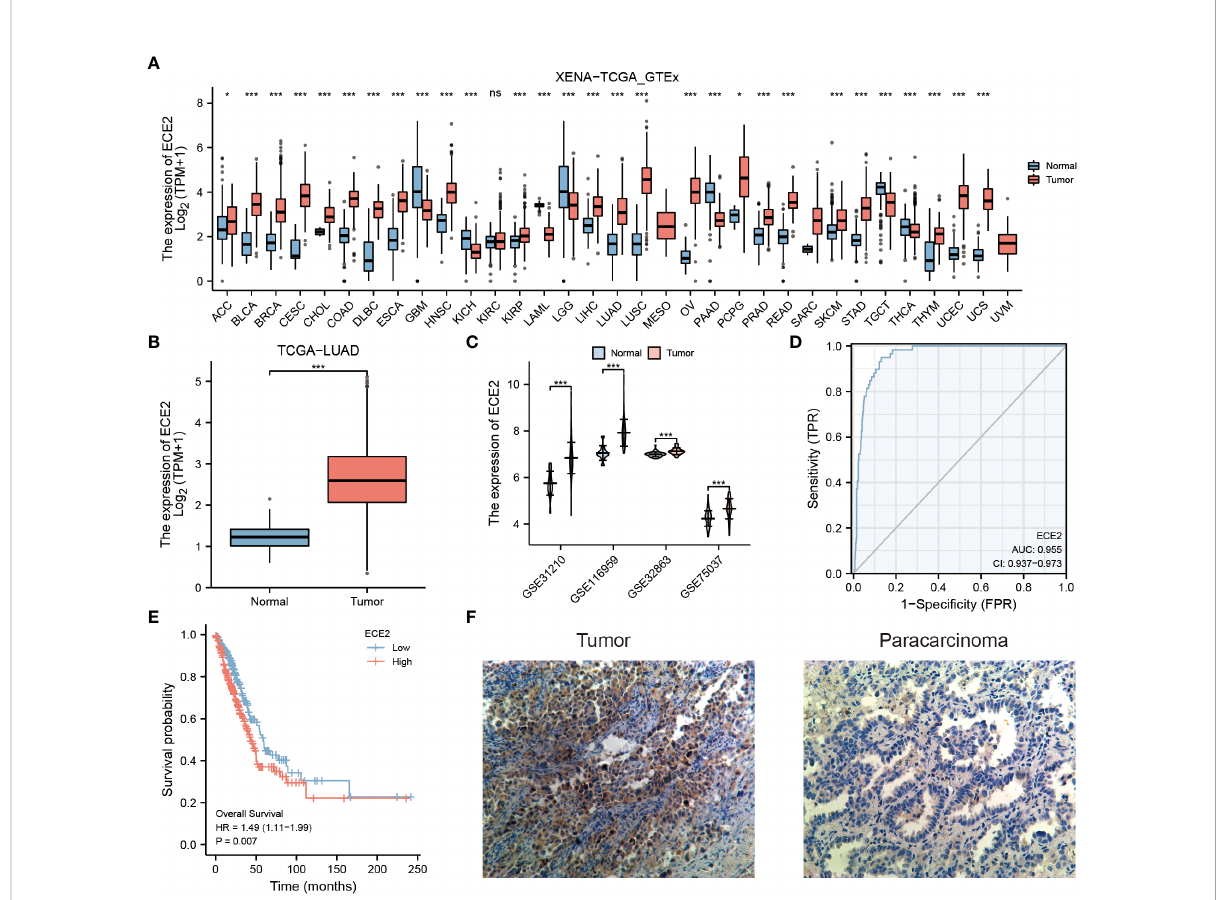
FIGURE 1 The expression of ECE2 in lung adenocarcinoma (LUAD) and pan-carcinoma. (A) The expression level of ECE2 in different tumors was evaluated with the XENA-TCGA_GTEx dataset (Wilcoxon rank sum test). (B) Boxplots of ECE2 expression between LUAD and normal tissue in the TCGA dataset (Wilcoxon rank sum test). (C) Differences in ECE2 expression between LUAD and normal tissues in GSE31210, GSE116959, GSE32863, and GSE70537 datasets (Wilcoxon rank sum test). (D) ROC curve analysis of ECE2 diagnosis. (E) The survival curve of ECE2. (F) Immunohistochemical analysis of ECE2 expression in LUAD tumor and para-cancer. *P < 0.05; ***P < 0.001. ns, not signi fi